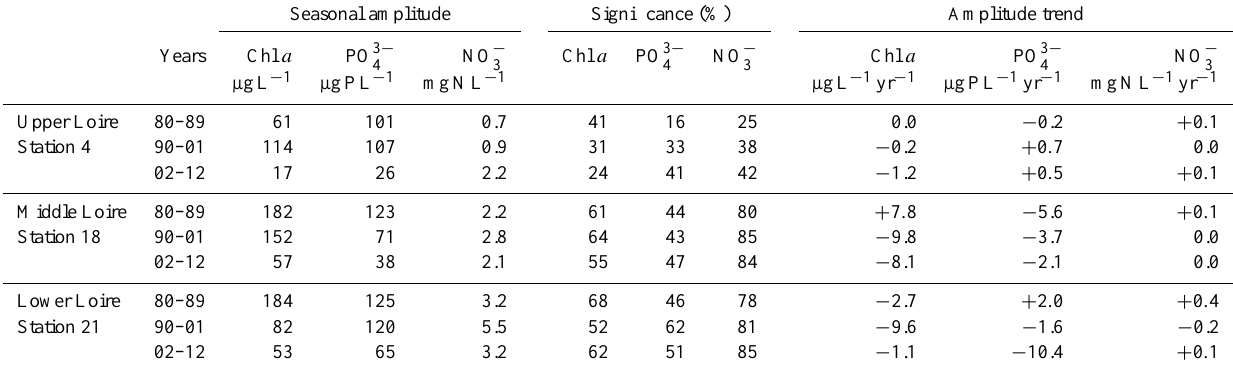
Seasonal amplitude Significance